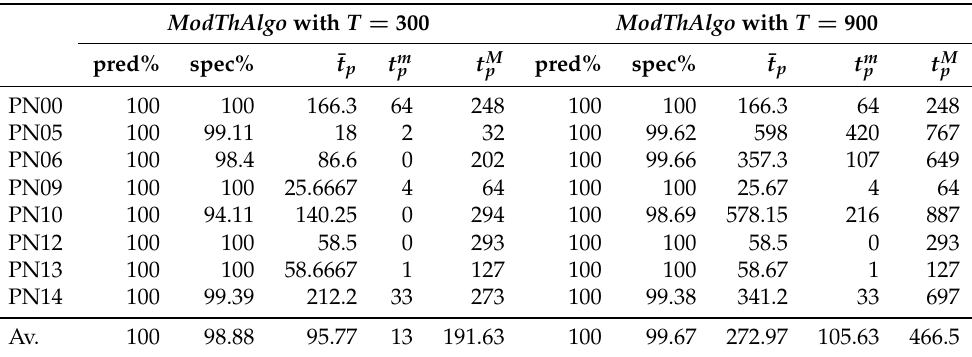
Table 4. Classification results of ModThAlgo with T = 300 and T =